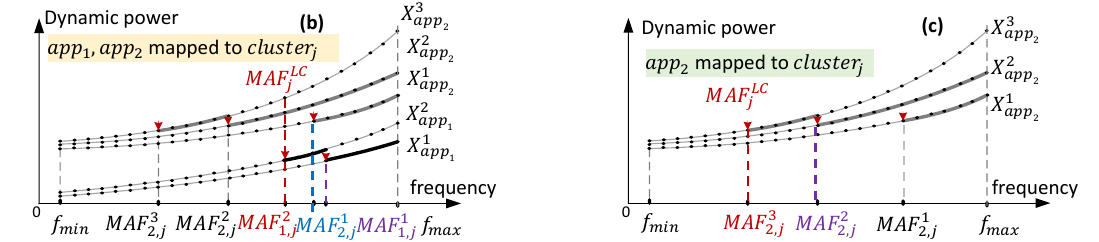
Figure 2. For u 1 = { app 1 , app 2 } executing on two-cluster platform: ( a ) all possible application-to- cluster mappings with some possible per-cluster DVFS, task-to-core mapping, and DPM configura- tions. ( b ) MAF and design-time mapping selection for case 1 where two applications are mapped to the same cluster. ( c ) MAF and design-time mapping selection for of app 2 in case 2 where one application is mapped to one